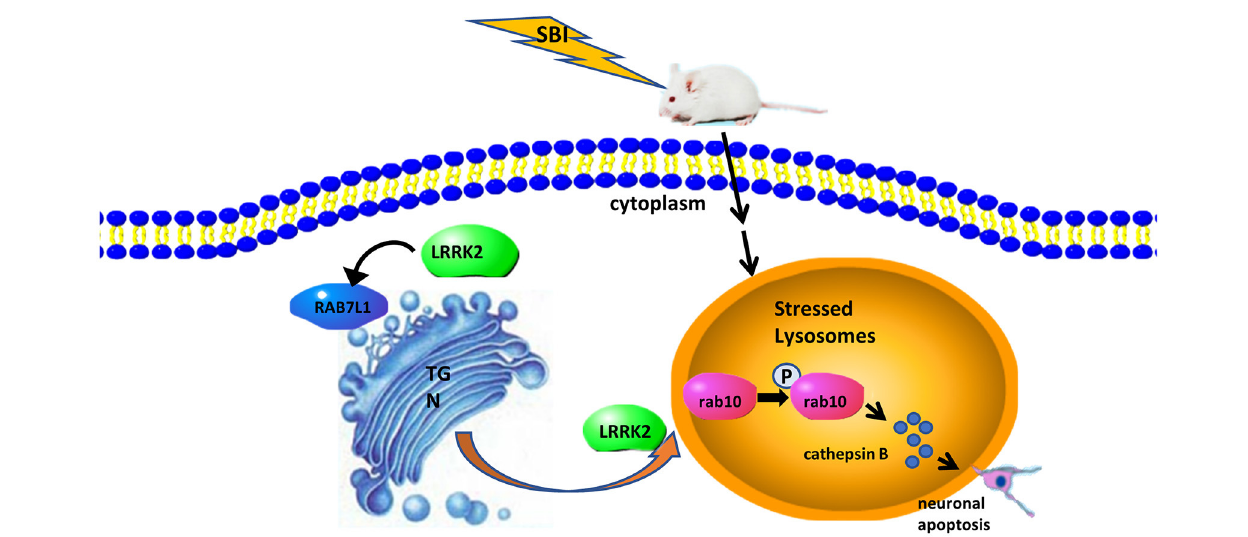
FIGURE 5 | The potential mechanism of LRRK2-Rab10 stress response pathway-mediated neuronal apoptosis after SBI. SBI induces lysosomal overload stress in neurons and results in a rapid increase in endogenous LRRK2 expression, which can activate the Rab10 phosphorylation pathway and allow it to specifically accumulate in lysosomes. Overexpressed p-Rab10 promotes excessive lysosomal secretion of lysosomal cathepsins in the neurons, leading to destruction of the plasma membrane, cell lysis, ultimately neuronal